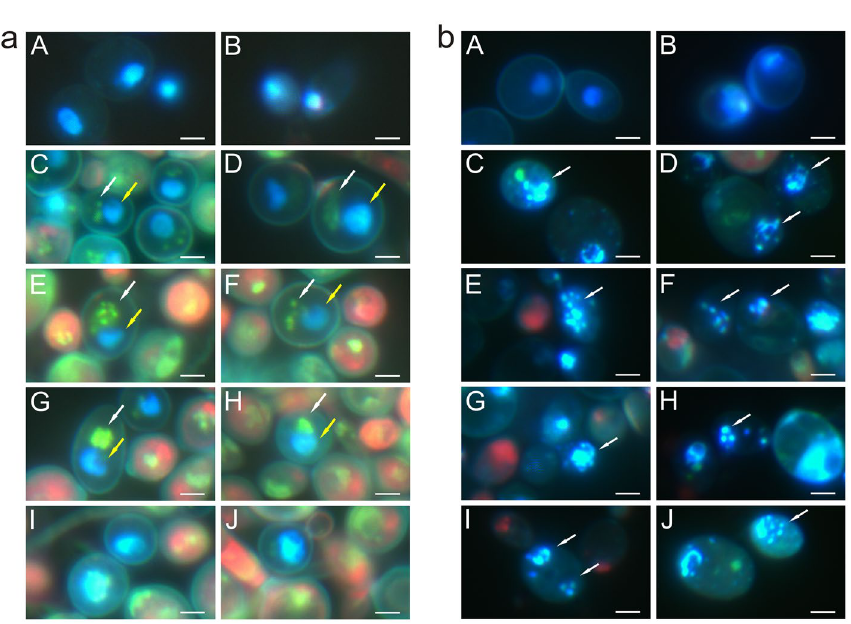
Figure 2. C. albicans cells after staining with Hoechst and propidium iodide: ( a ) Migration of mitochondrial DNA into nuclear DNA: ( A , B ) control cells, ( C – J ) cells treated with AAF (100 µg mL −1 ); ( C , D ) blue fluorescent surface of nuclei (yellow arrows), green glowing of mitochondrial DNA (white arrows); ( E , F )migration of mitochondrial DNA to nuclear DNA; ( G , H ) fusion of mitochondrial DNA and nuclear DNA into one structure, ( I , J ) cells with enlarged nuclei formed after fusion of mitochondrial DNA with nuclear DNA; ( b ) Apoptosis: ( A , B )—control cells, ( C – J ) cells treated with AAF (100 µg mL −1 ), cells undergoing the apoptotic process with fragmented genetic material fluorescing intense light blue (marked by white arrows). Bars represent 2